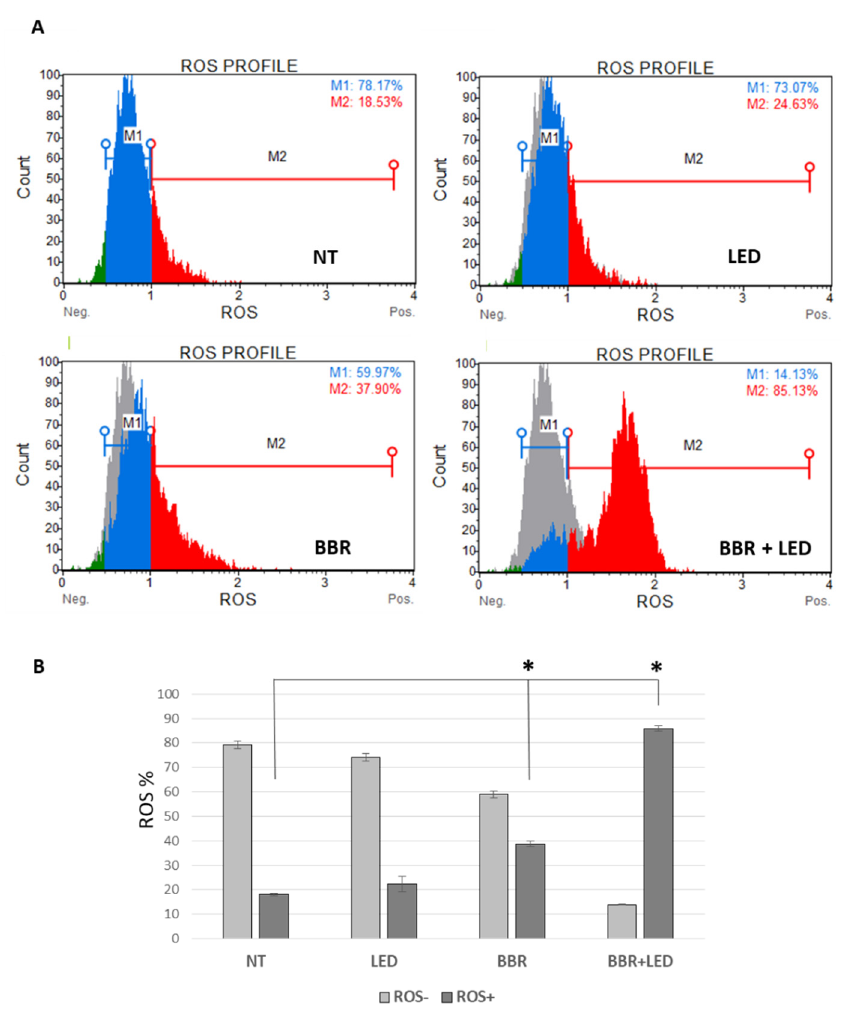
Figure 10. Oxidative stress analysis. Cytofluorimetric analysis of Reactive Oxygen Species (ROS) in T98G cells as untreated (NT), exposed to LED stimulation (LED), BBR (200 µ g/mL for 4 h) administration and with the combined LED+BBR, evaluated after 24 h p.t. ( A ). Trypsinized cells were analyzed for count and percentage of cells undergoing oxidative stress based on the intracellular detection of ROS using the Muse Oxidative Stress kit (Luminex). The histogram of the averages of three replicas of ROS- (M1 gate) and ROS+ (M2) cells percentage is reported ( B ). Asterisks indicated statistical significance compared to untreated cells ( p < 0.05, Anova One-way).